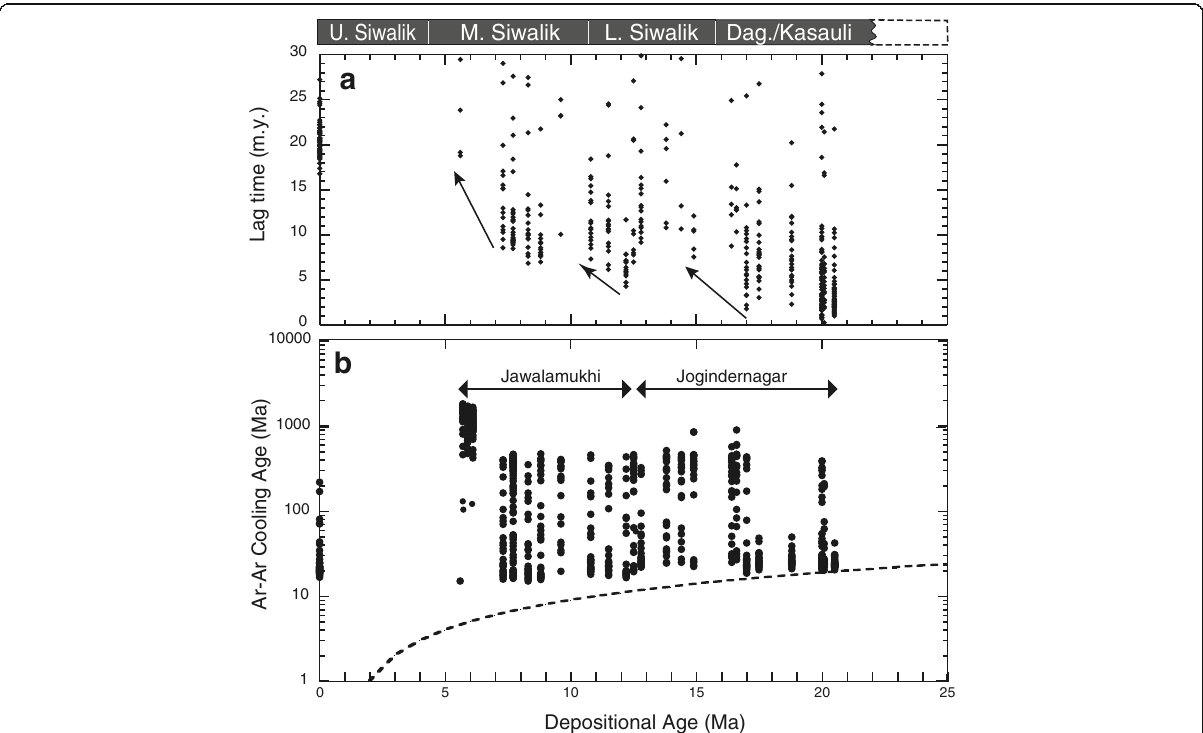
Fig. 8 Comparison of Ar-Ar muscovite cooling ages and depositional ages from the Jawalamukhi section of Najman et al. (2009) and the Jogindernagar section of White et al. (2002). Note that increase in lag of fastest cooled grains after ~17 Ma and ~8 Ma. a Lag times between cooling and sedimentation. b The cooling and deposition ages with the dashed line indicating zero lag